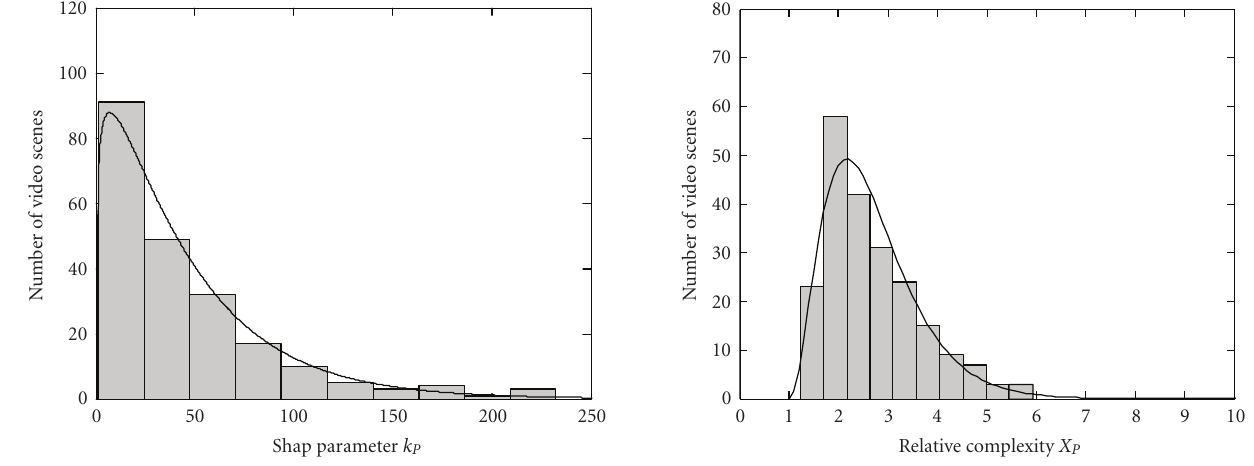
Figure 2: Histogram of shape parameter for Gamma distributions of P frames ( k P ) over video scenes that is fitted to a Gamma PDF.